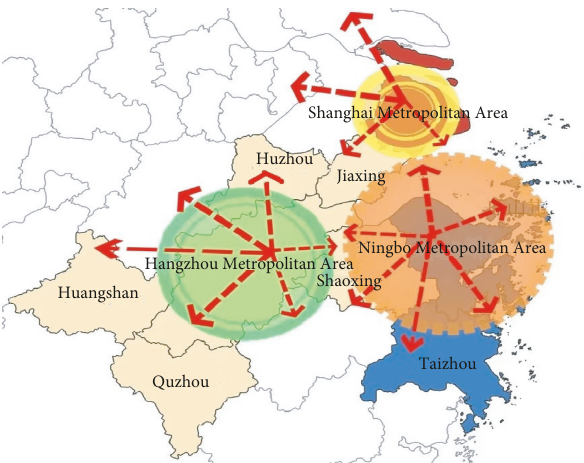
Figure 5: Logistics radiation range of each metropolitan